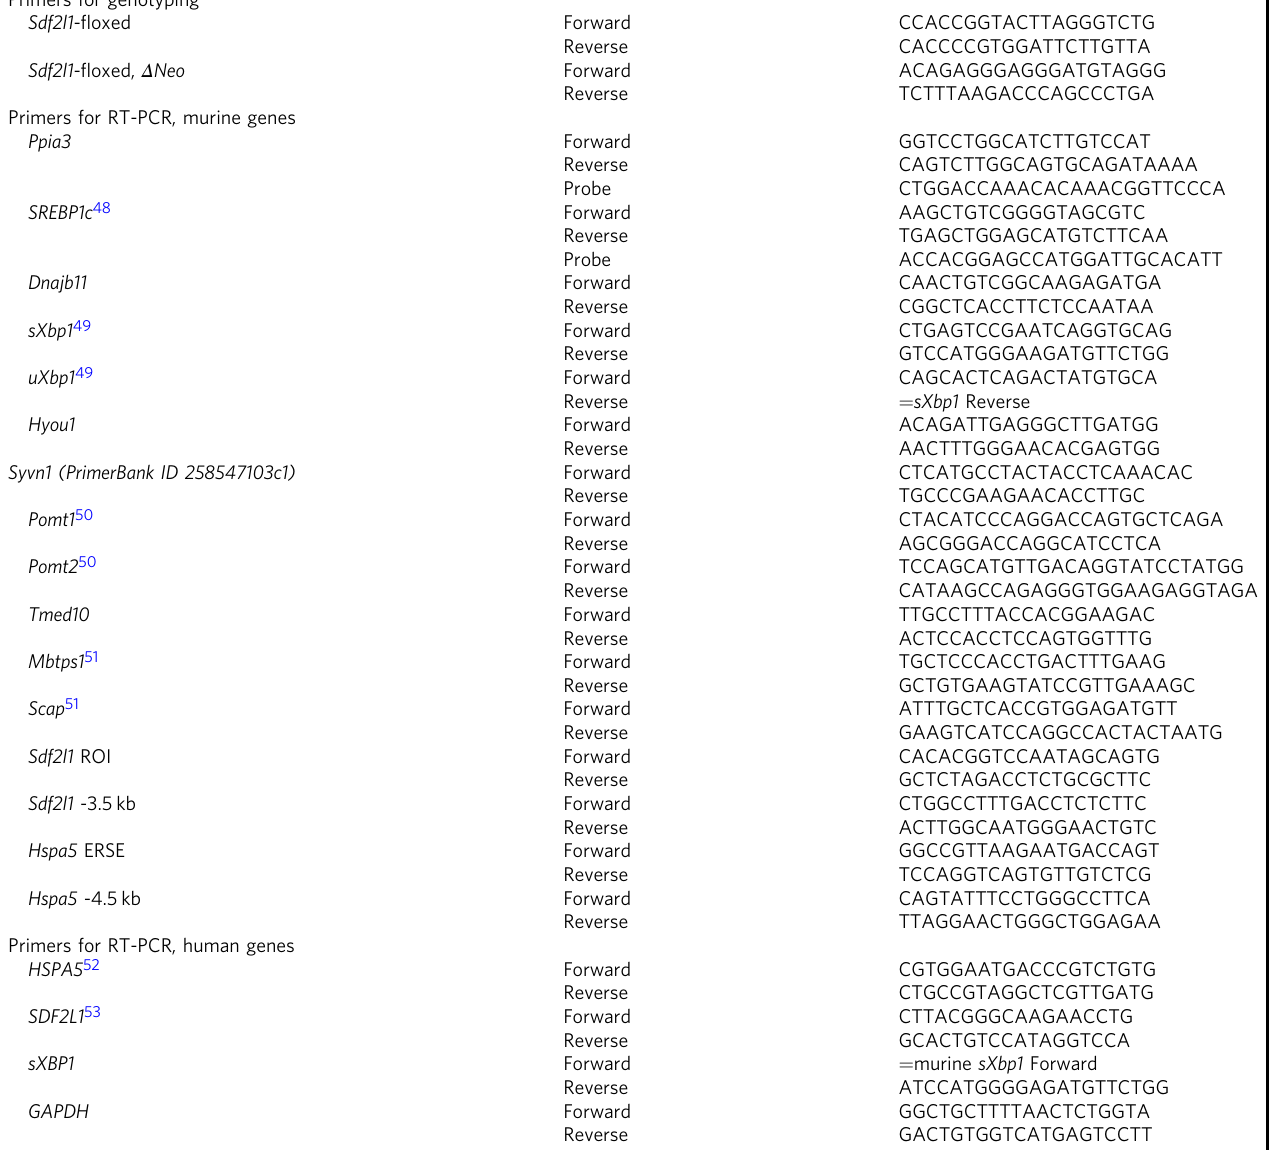
Sdf2l1 - fl oxed, external